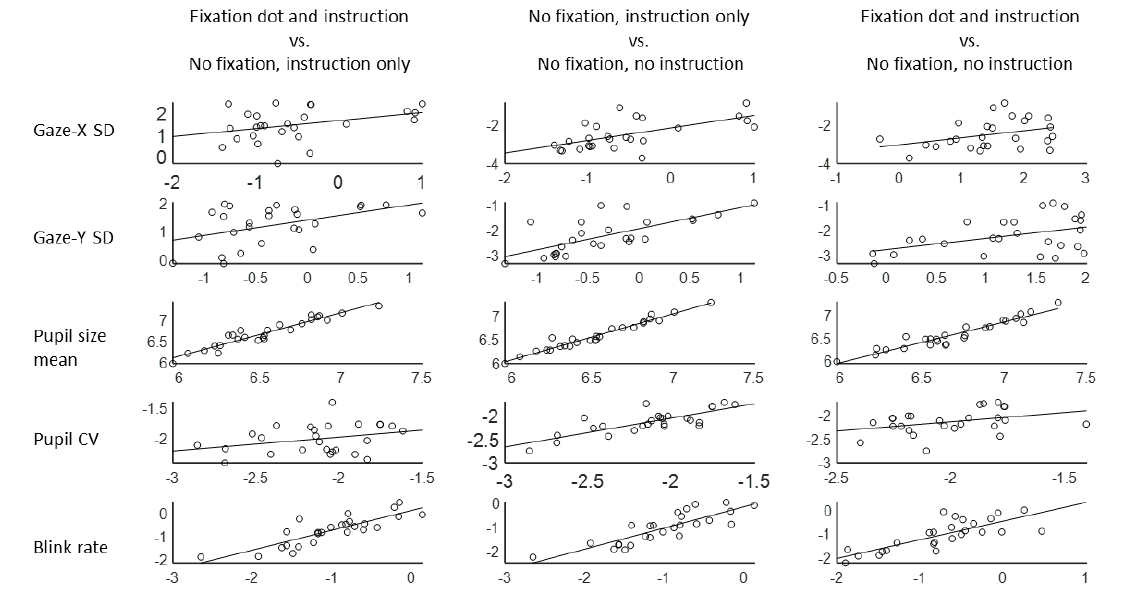
Figure 6. Correlation plots between the three different conditions (‘Fixation plus instruction’, ‘No fixation, instruction only’, and ‘No fixation plus no instruction’) on each of the four oculomotor measures from Experiment 3. Overall, evidence favours the exist- ence of correlations – suggesting good intra-individual reliability of oculomotor variability over the different conditions. Note that the measures are